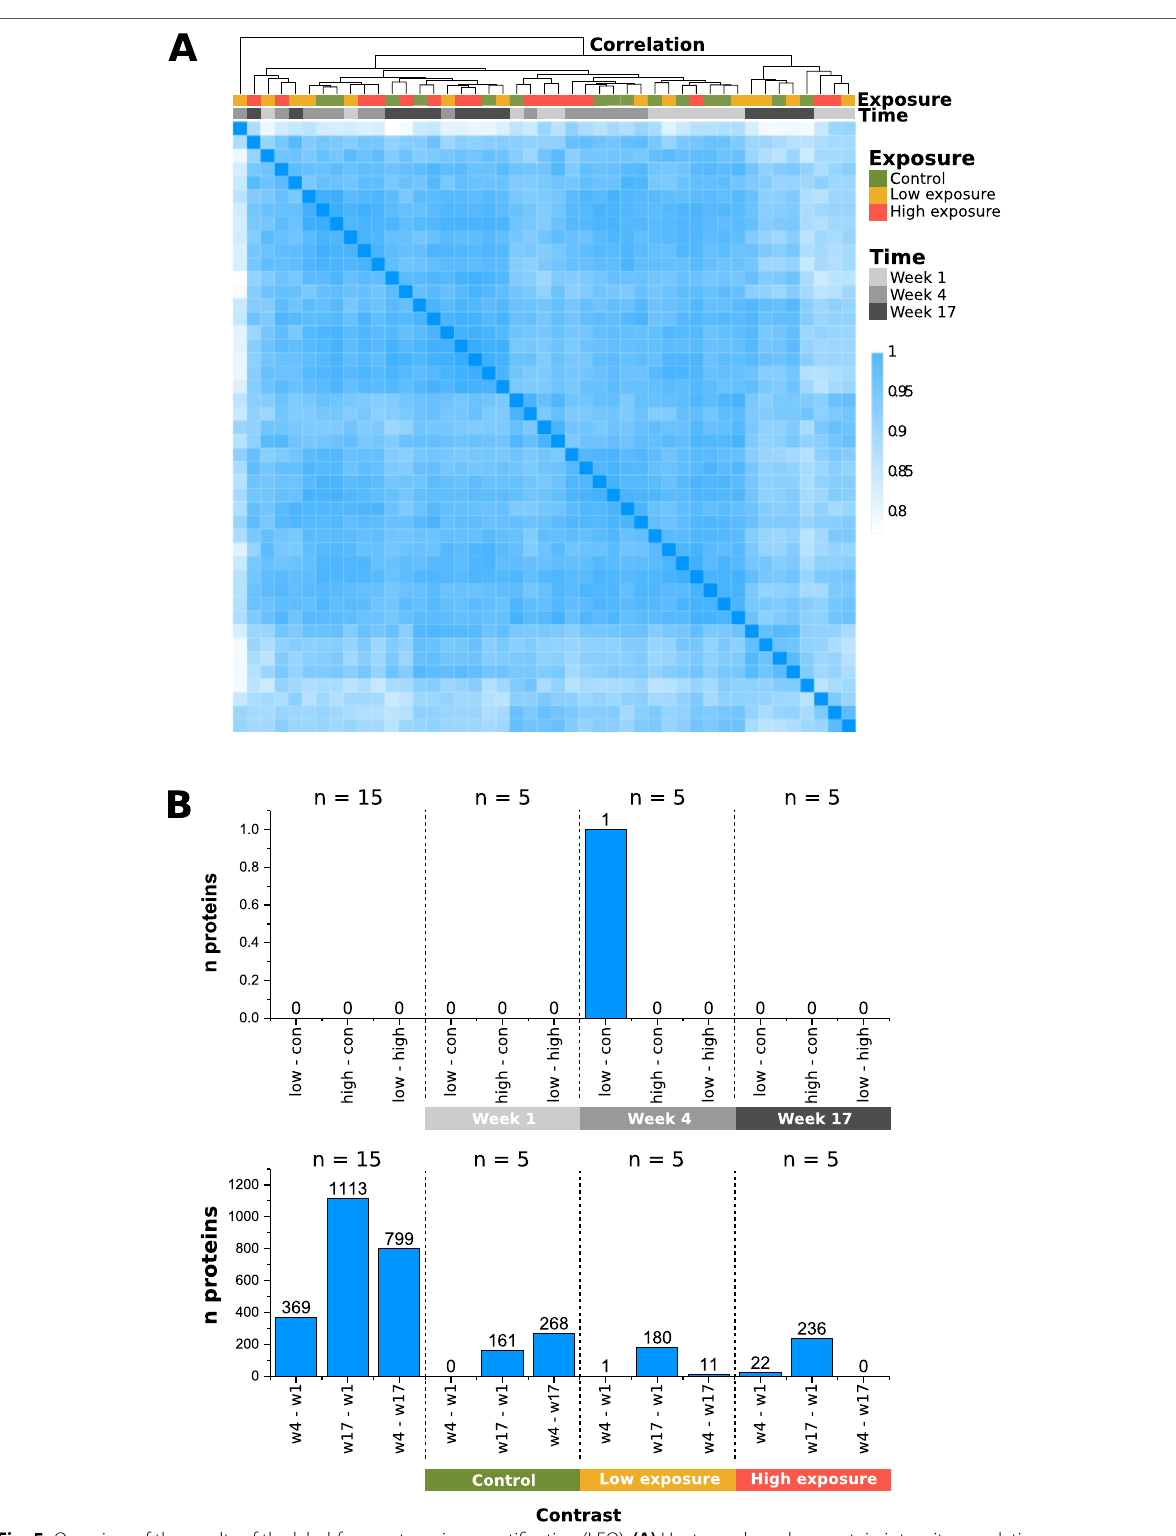
week, con control, low low = = =